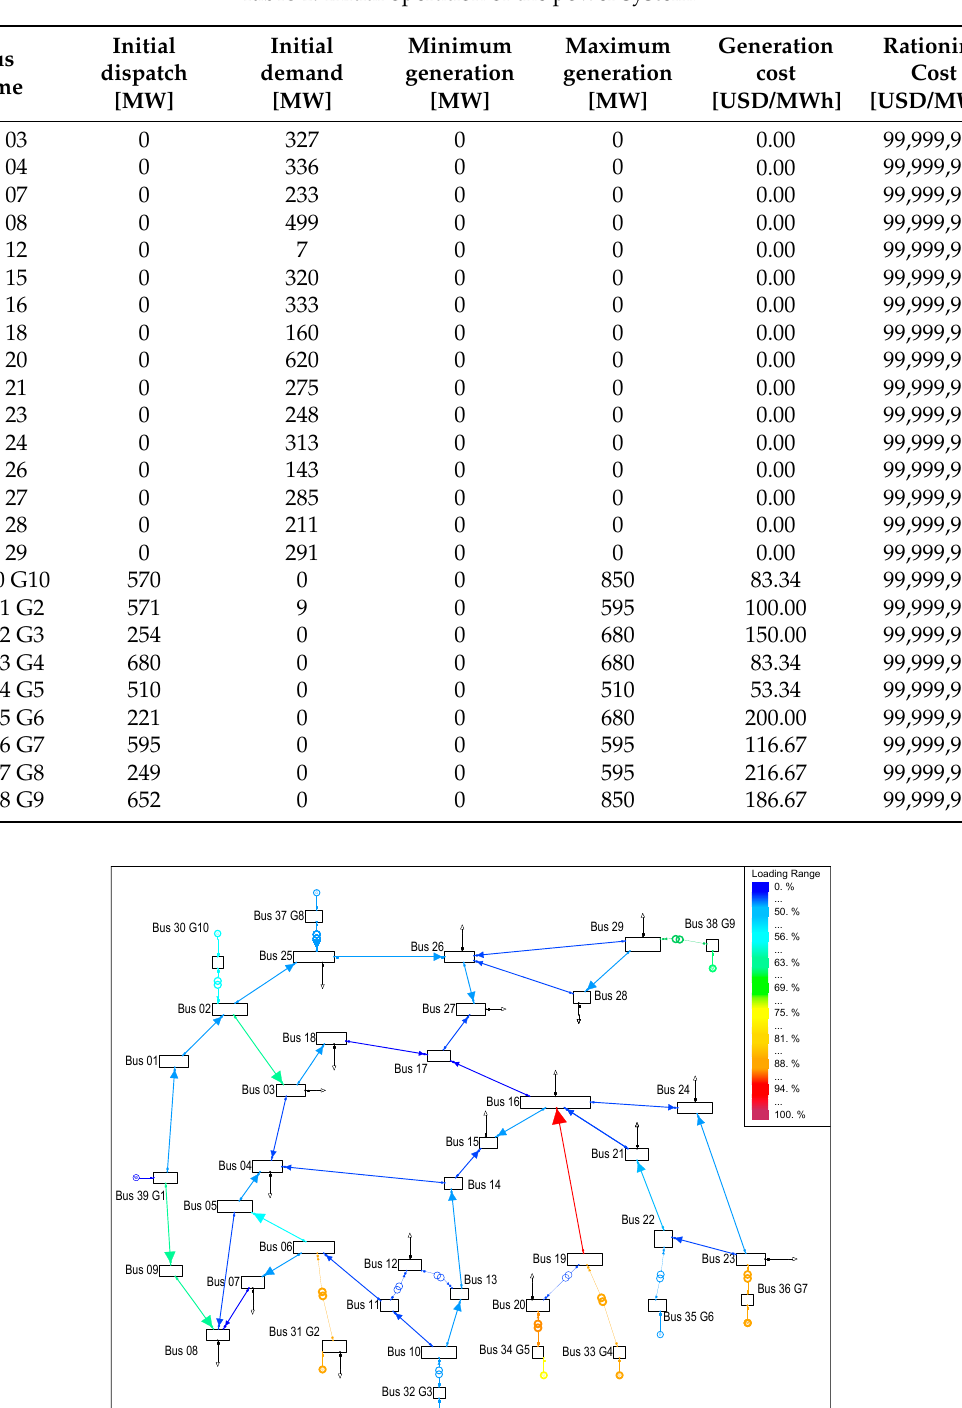
Figure 4. Maximum loadability without N − 1contingencies.